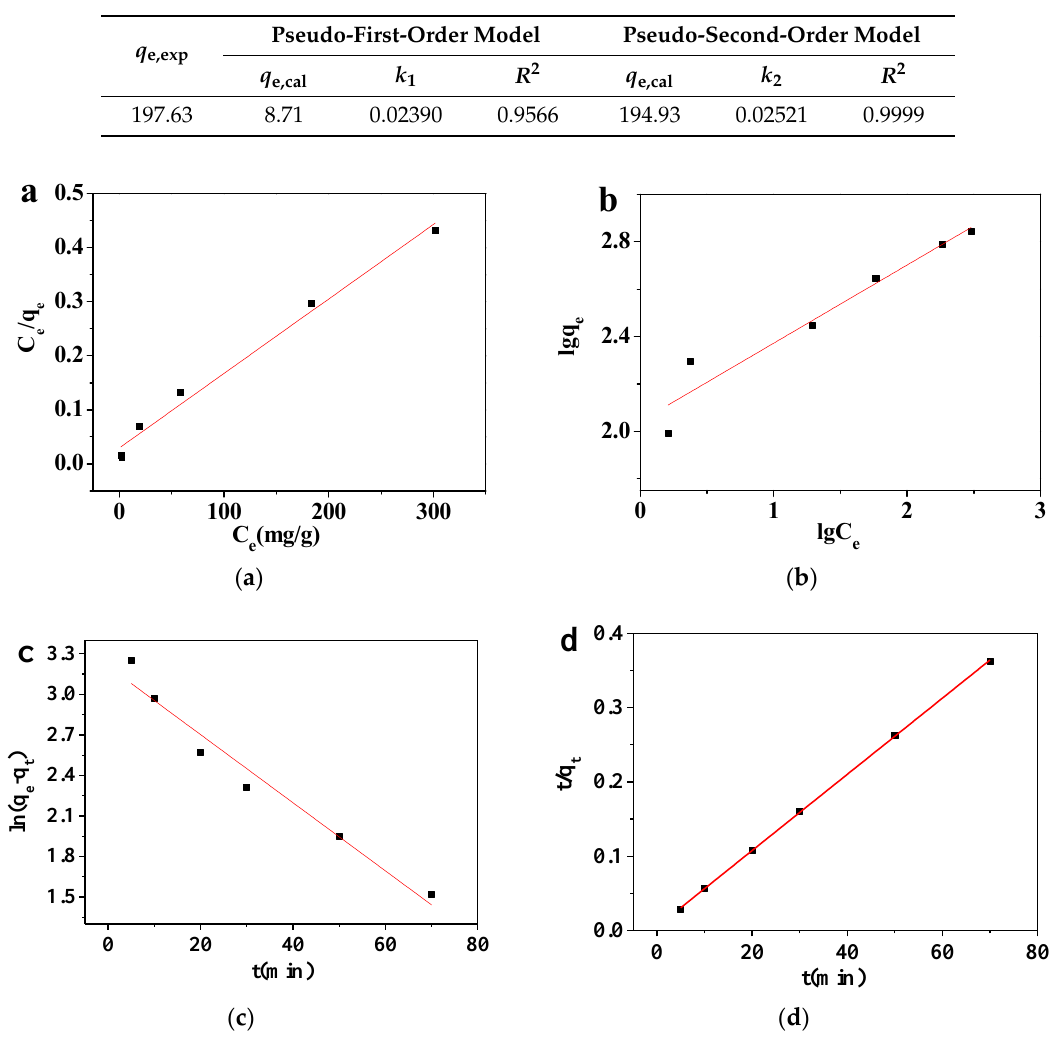
Figure 7. Fitting curves of the Pb(II) adsorption process by MMMT@Zn-BDC: ( a ) the Langmuir and ( b ) the Freundlich isotherm models, ( c ) a pseudo-first order and ( d ) a pseudo-second order kinetic models.